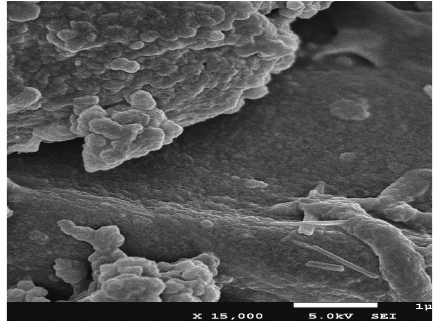
Figure 3: SEM of CaHBSD after copper adsorption.